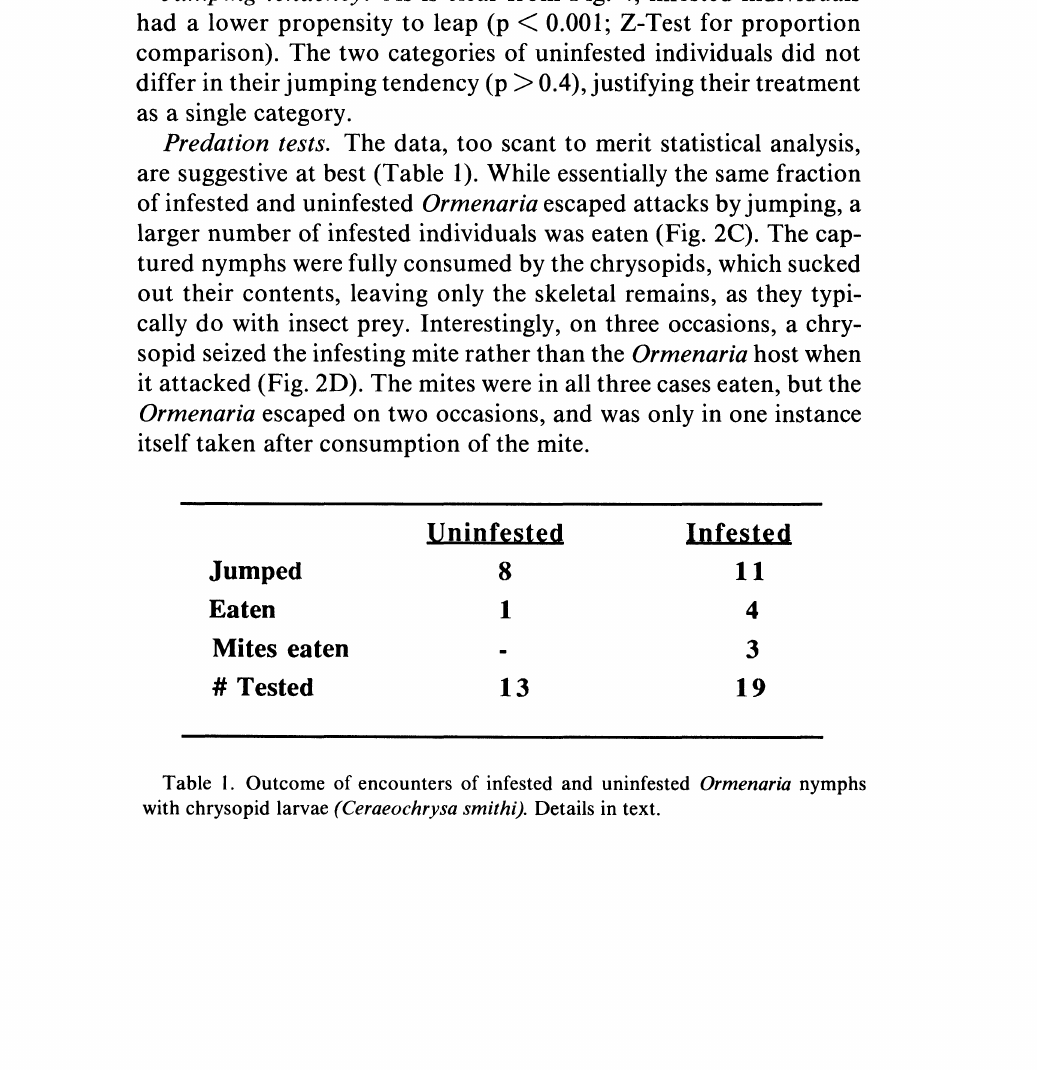
Table 1. Outcome of encounters of infested and uninfested Ormenaria nymphs with chrysopid larvae (Ceraeochrysa smithi). Details in